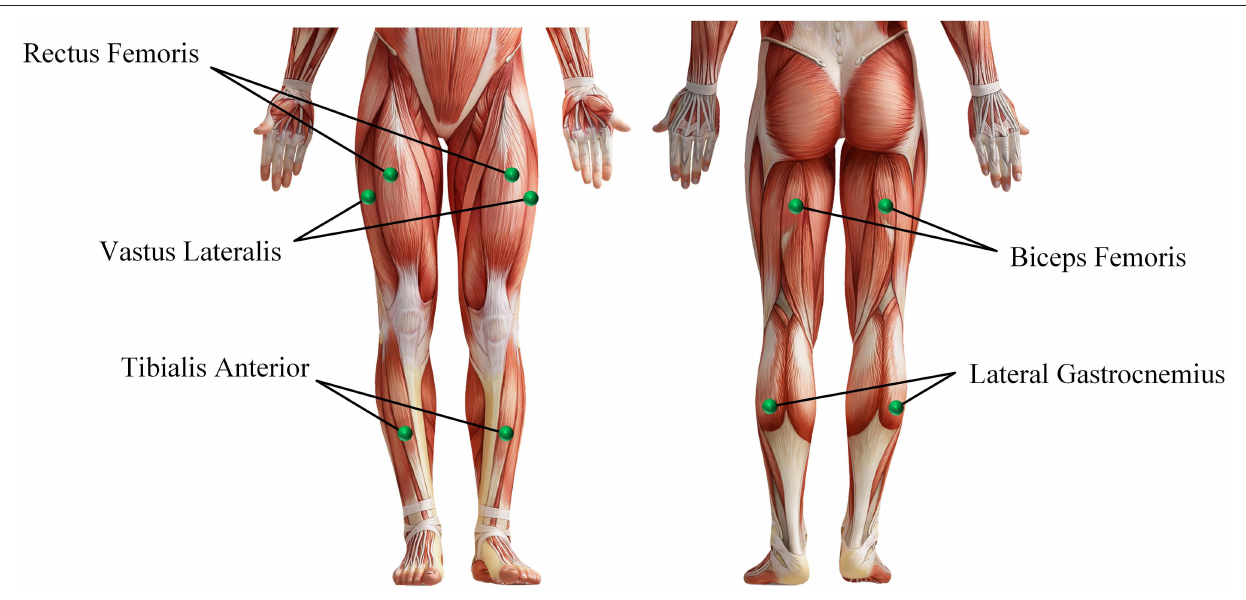
FIGURE 4 | The muscle used in the sEMG and EEG data acquisition experiment.